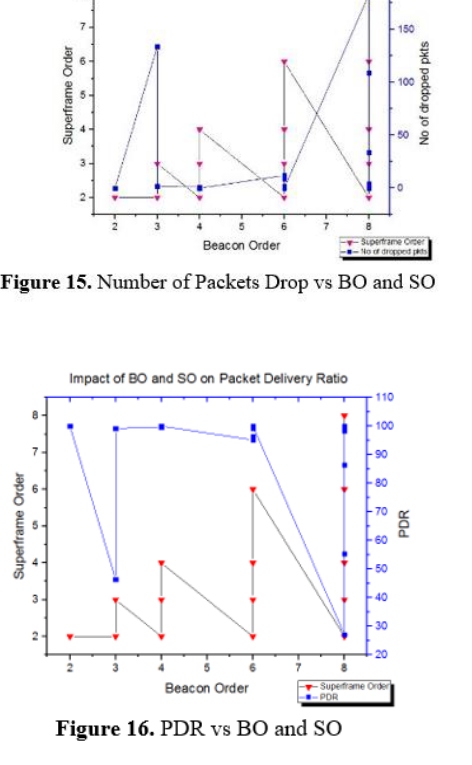
Figure 16 represent the Packet Delivery Ratio (PDR), our simulation results show that when BO is equal to SO then PDR is 100%. And when we keep SO decreasing then PDR is going down gradually, the rate of PDR decreasing is much high at